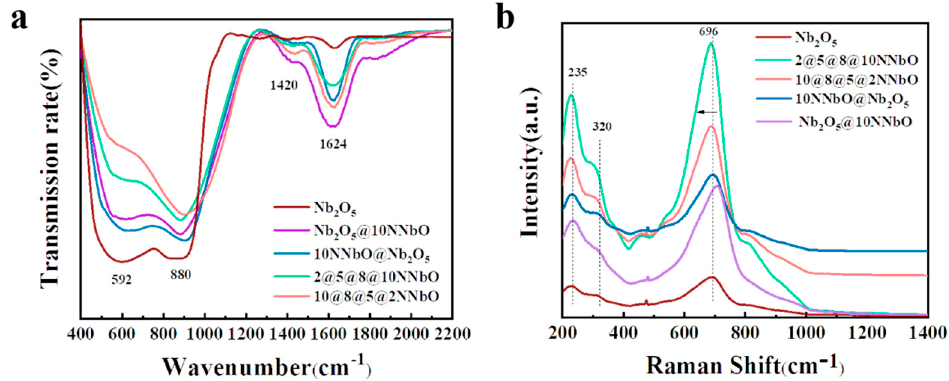
Figure 2. ( a ) FT − IR and ( b ) Raman spectra of pure Nb 2 O 5 , 2@5@8@10NNbO, 10@8@5@2NNbO, 10NNbO@Nb 2 O 5 and Nb 2 O 5 @10NNbO.